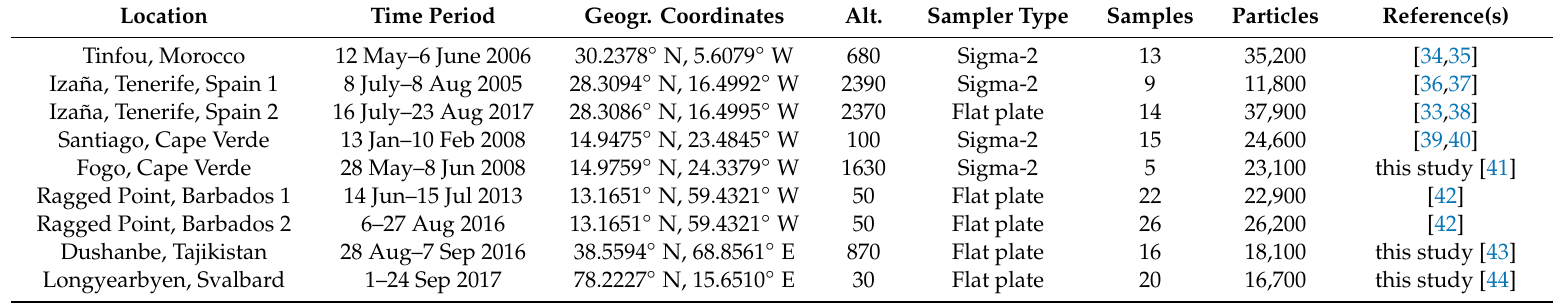
Table 1. Measurement locations and time periods, collector type, number of samples, number of particles analyzed, and reference / data reference. ‘Alt’ denotes the altitude above sea level in